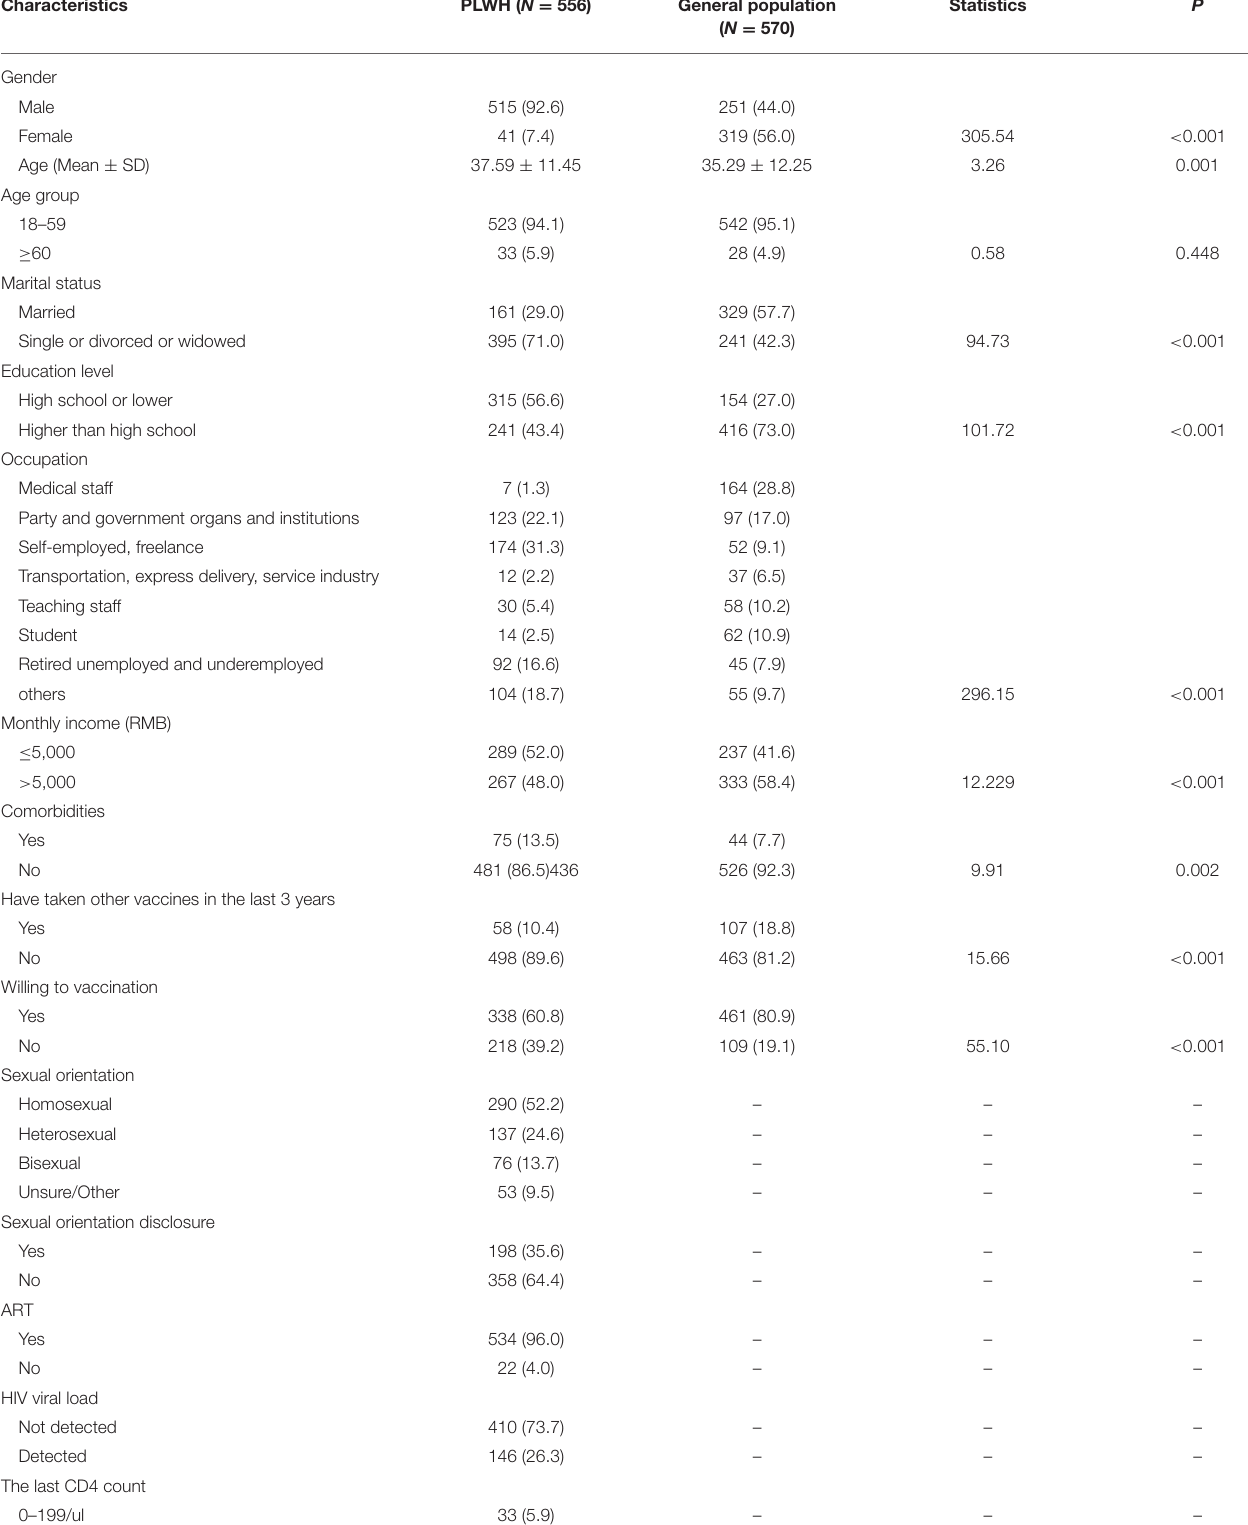
TABLE 1 | Descriptive characteristics of all participants in Wuhan, China, 2021 ( N =